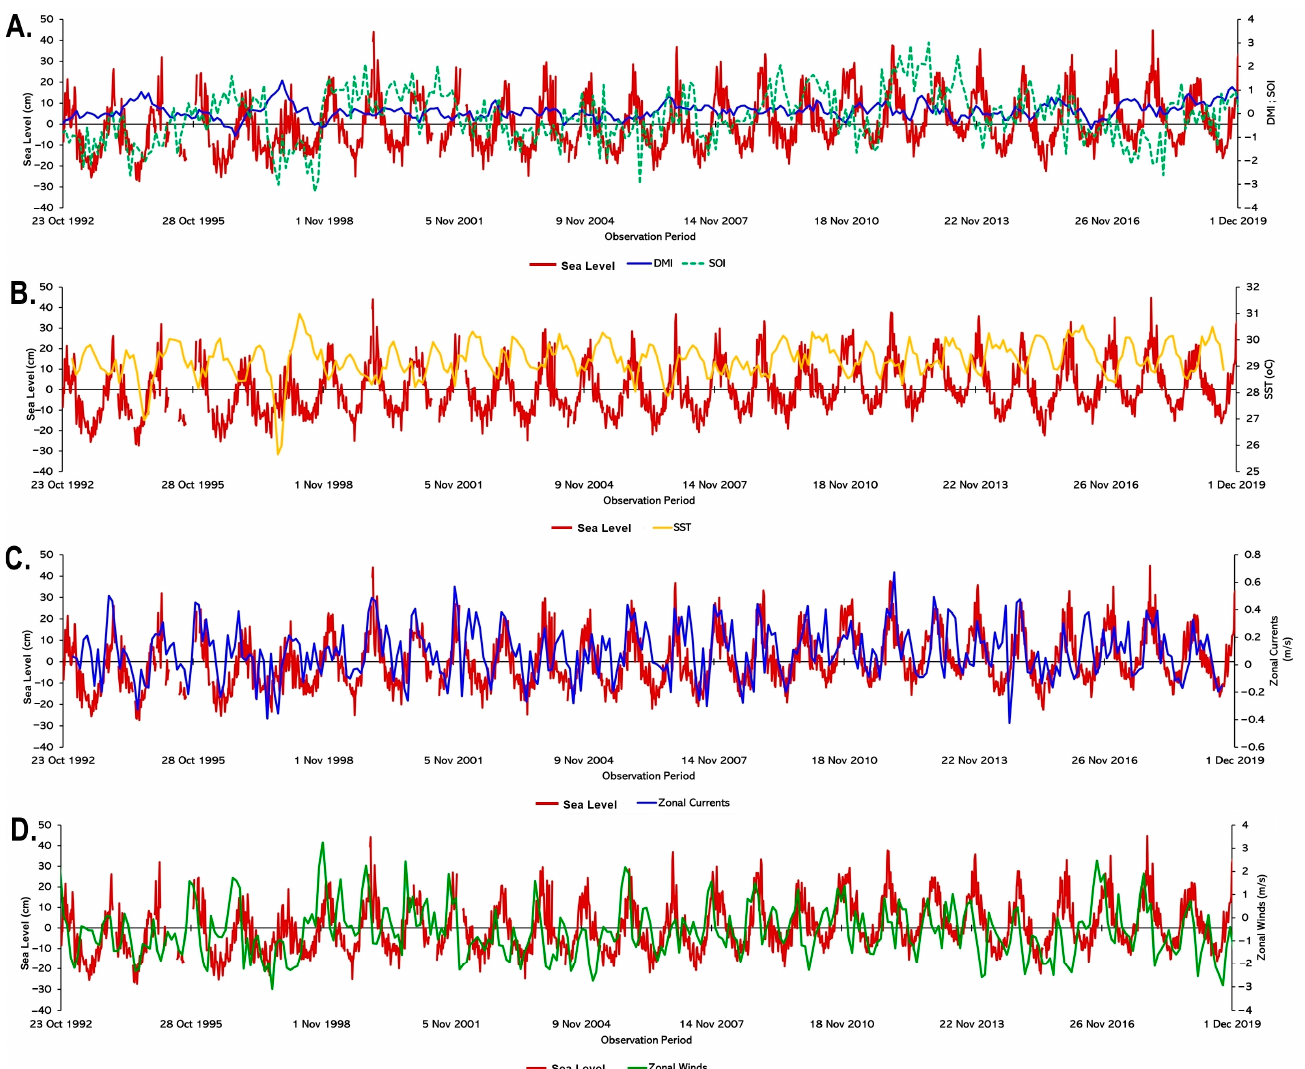
Figure 3. Interannual comparison of sea level anomaly data with climatic–oceanographic factors; sea level vs. DMI_SOI ( A ); sea level vs. SST ( B ); sea level vs. zonal currents ( C ); and sea level vs. zonal winds ( D ).